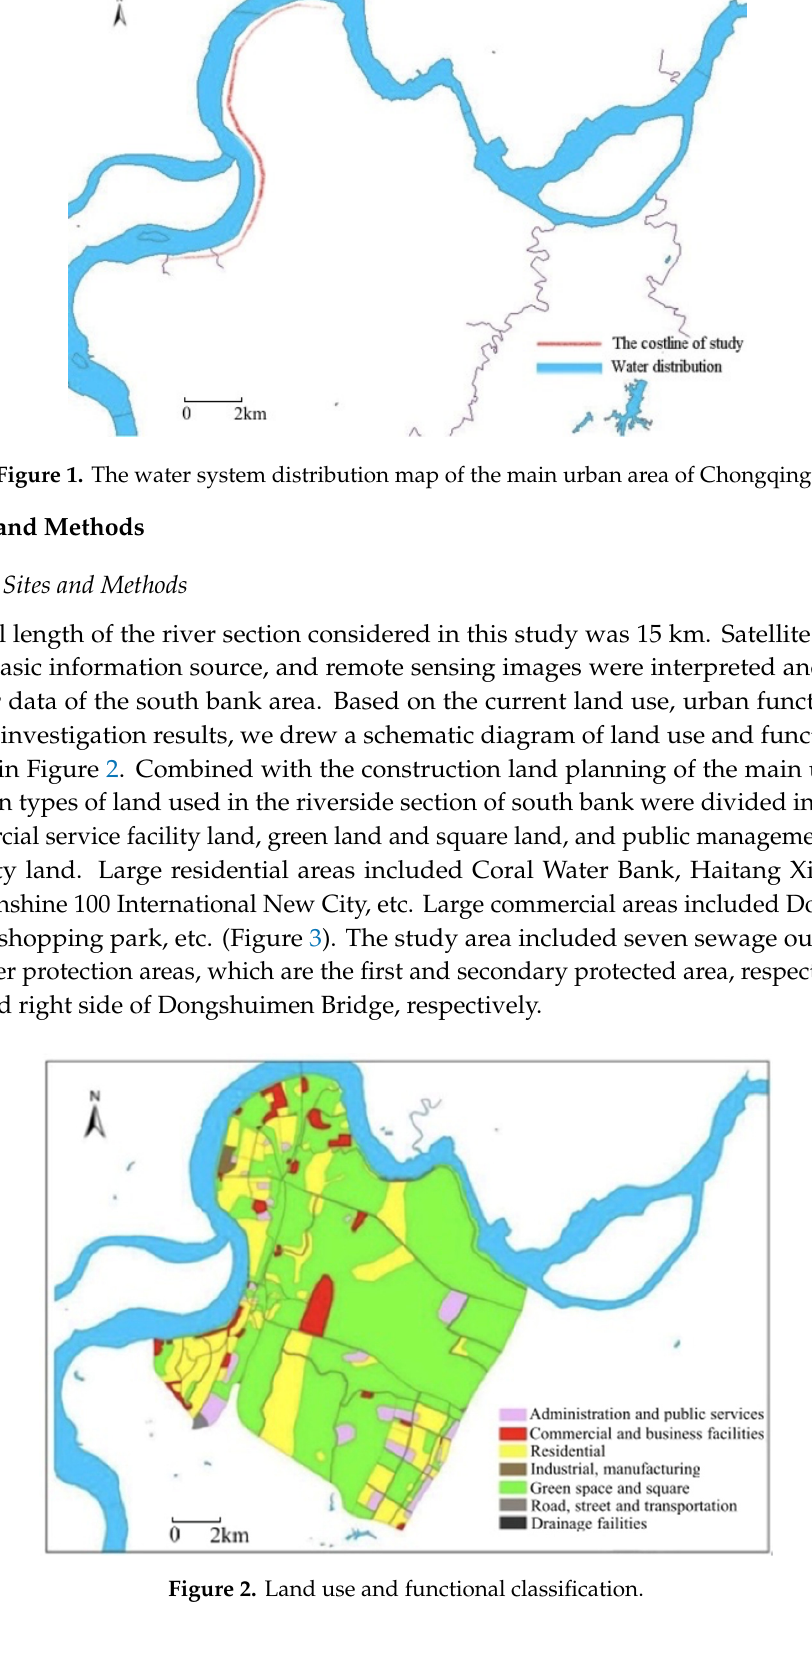
Figure 2. Land use and functional classification.